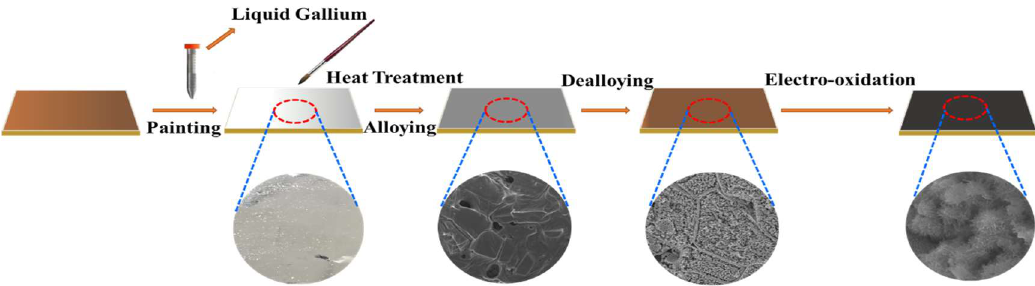
Figure 1. Schematic diagram of the fabrication process of the Cu x O/Cu electrodes. After dealloying in 0.2 M HNO 3 solution, nanoporous structures evolved on the surface of the dealloyed Cu foil, which inherits from the Ga-Gu alloys, as shown from the back-scattering SEM image (Figure S1a). The diameter of the dealloyed Cu